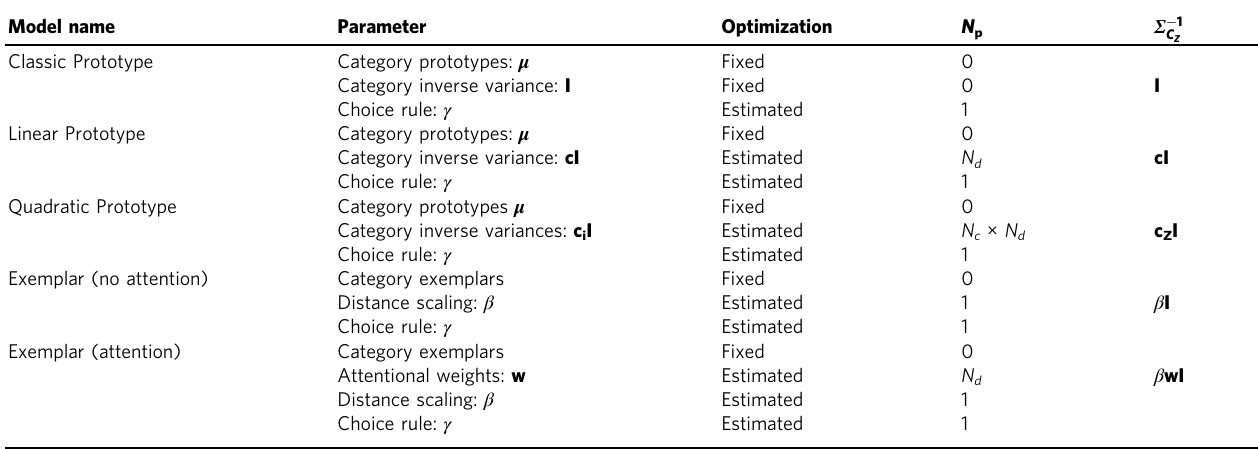
Table 1 Categorization model variants: descriptions and